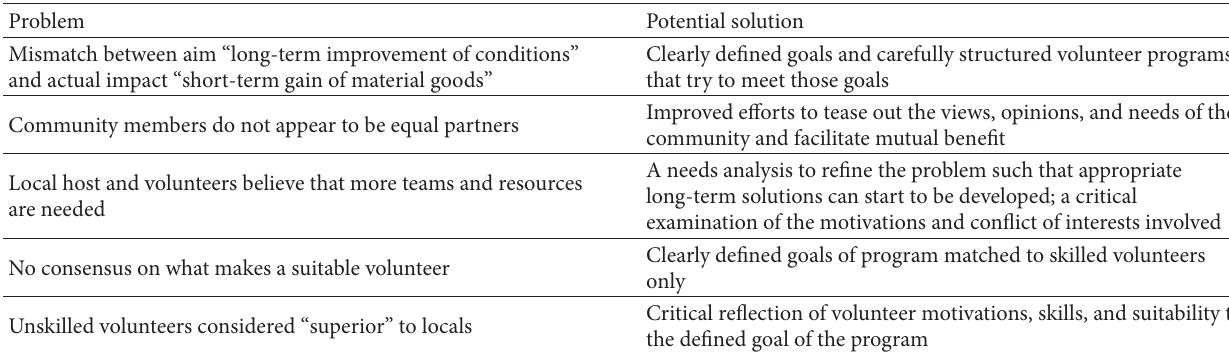
Table 4: Identified problems and